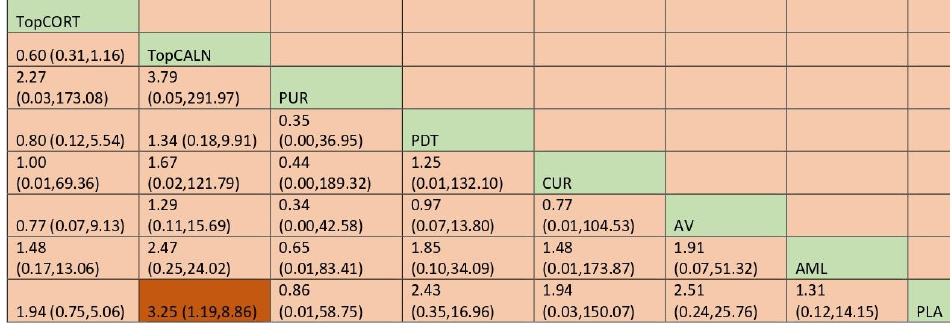
Figure 6. League table for adverse effects. Abbreviations: AML, amlexanox paste; AV, aloe vera; CUR, curcumin gel; PDT, photodynamic therapy; PLA, placebo; PUR, purslane; SysCORT, systemic corticosteroid; TopCALN, topical calcineurin; TopCALNcoSysCORT, topical calcineurin combined with systemic corticosteroid; TopCORT, topical corticosteroid. The green gihlights indicate the interventions and the dark highlights indicate the significant results.